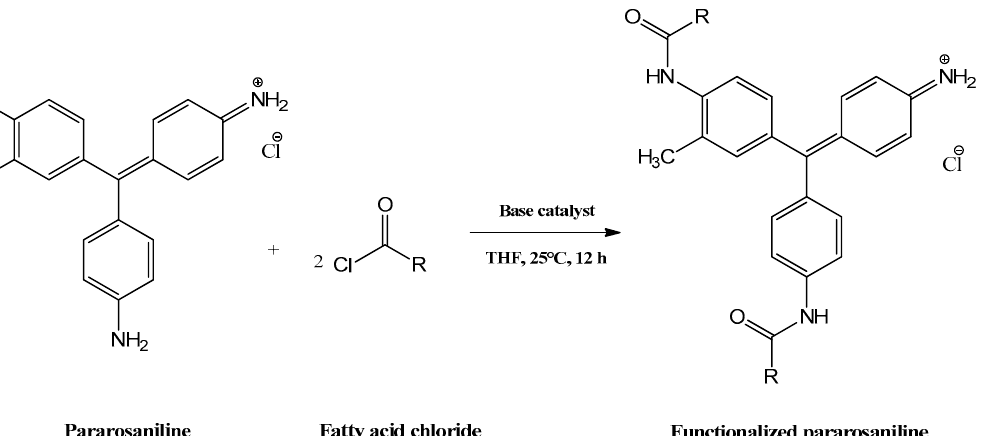
Figure 1. Scheme of direct coupling reaction of amino groups of pararosaniline with fatty acid chlo- rides catalyzed with bases over mild